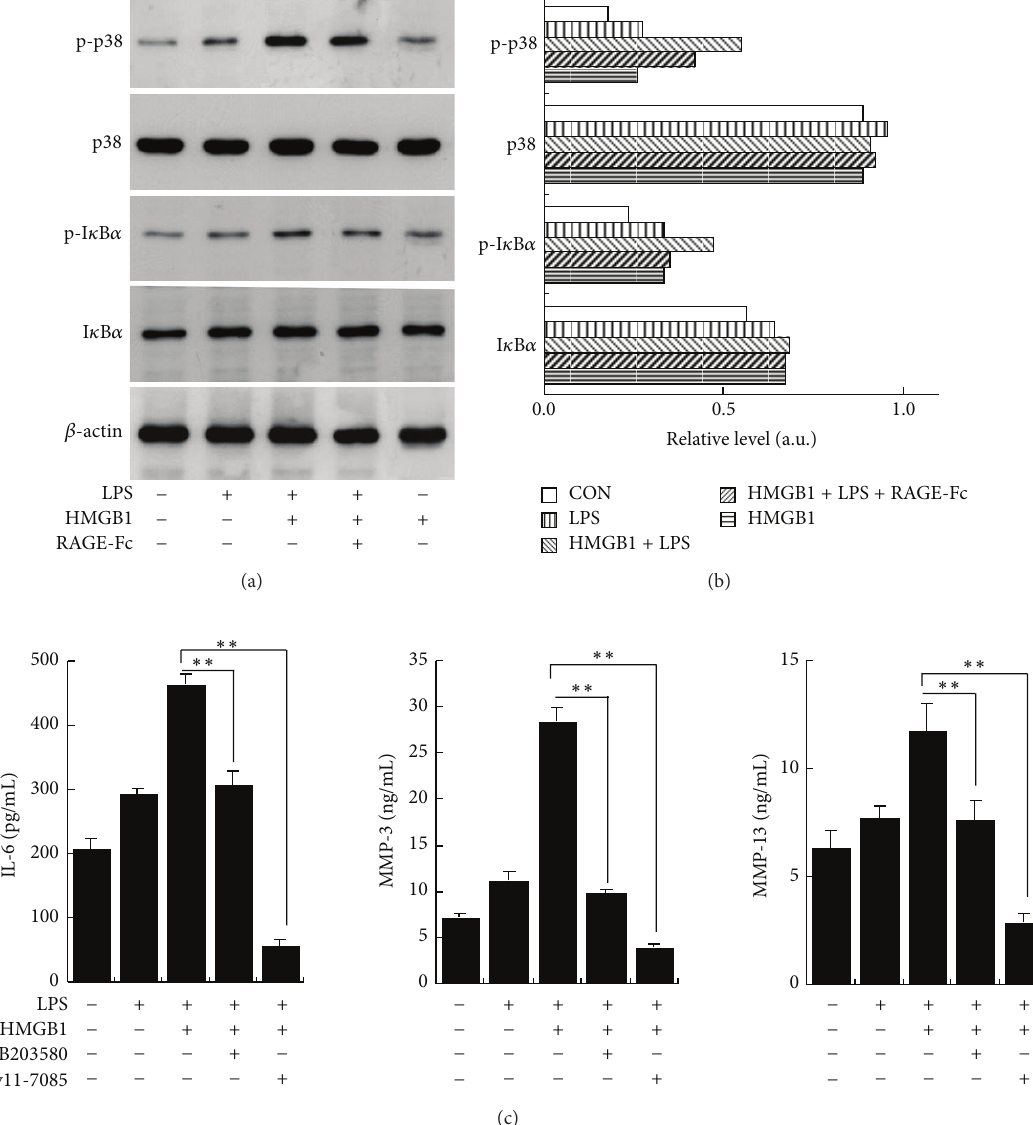
Figure 5: HMGB1 and LPS synergistically activated NF- 𝜅 B and p38 MAPK. MAPK: mitogen-activated protein kinase; p-p38: phosphorylated p38; p-I 𝜅 B: phosphorylated I 𝜅 B. (a) Levels of intracellular molecules in whole cell lysates were analyzed by Western blotting after the SF were stimulated with 10 ng/mL of LPS and/or 100 ng/mL of HMGB1 for 30 min. To test whether RAGE mediate the effect of HMGB1 plus LPS, SF were pretreated with RAGE-Fc (10 𝜇 g/mL) for 30 min prior to the stimulation with HMGB1 plus LPS. (b) Densitometry analysis of the Western blot bands which was adjusted by the density of corresponding band of 𝛽 -actin. (c) Cultured SF were pretreated with NF- 𝜅 B inhibitor Bay11-7085 (20 𝜇 M) or p38 inhibitor SB203580 (10 𝜇 M) for 1 h and then incubated with 10ng/mL of LPS and/or 100 ng/mL of HMGB1 for 48 h. The concentrations of IL-6, MMP-3, and MMP-13 proteins in culture supernatants were measured by ELISA. Data are expressed as mean ± SD ( 𝑛 = 4 ). ∗ 𝑃 < 0.05 and ∗∗ 𝑃 < 0.01 compared with SF stimulated with HMGB1 plus